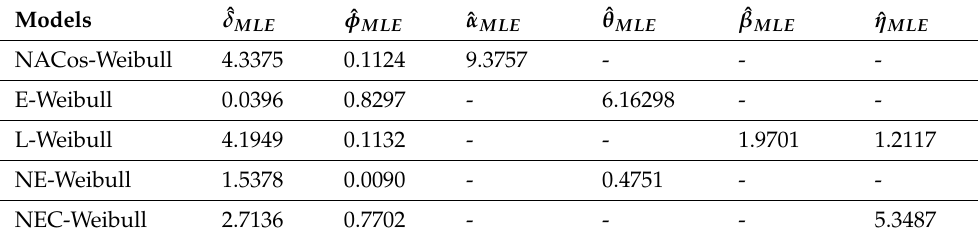
Table 11. Using the glass fibers data set, the values of ˆ δ MLE , ˆ φ MLE , ˆ α MLE , ˆ θ MLE , ˆ β MLE , and ˆ η MLE of the fitted